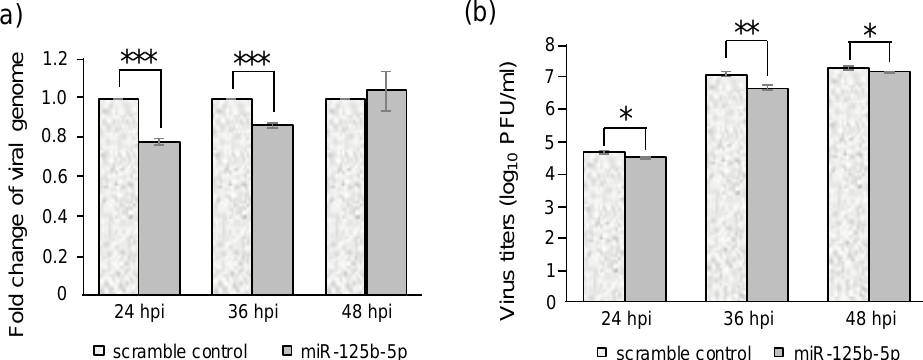
Figure 4. Transfecting excess amounts of miR-125b-5p inhibited JEV replication. BHK-21 cells were transfected with miR- 125b-5p (0.5 nM) or a scramble control and then infected with JEV at an MOI of 0.1 at 24 h post-transfection. ( a ) Cytoplasmic RNA was extracted at the indicated time post-infection. The fold change of viral RNA was analyzed using RT-qPCR. ( b ) The supernatant was collected, and virus titers were determined by plaque assay. Bars represent the mean ± SD ( n = 3). *: p -value < 0.05; **: p -value < 0.01; *** p -value < 0.001 compared with scramble control and analyzed by Student’s t -test.